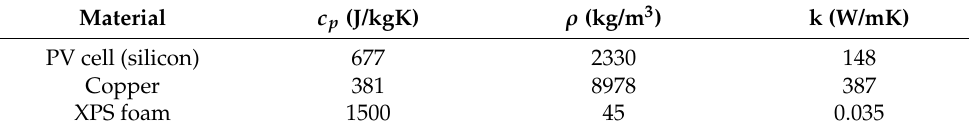
Table 4. Thermophysical properties of the materials used in PV/T panel [27–31].